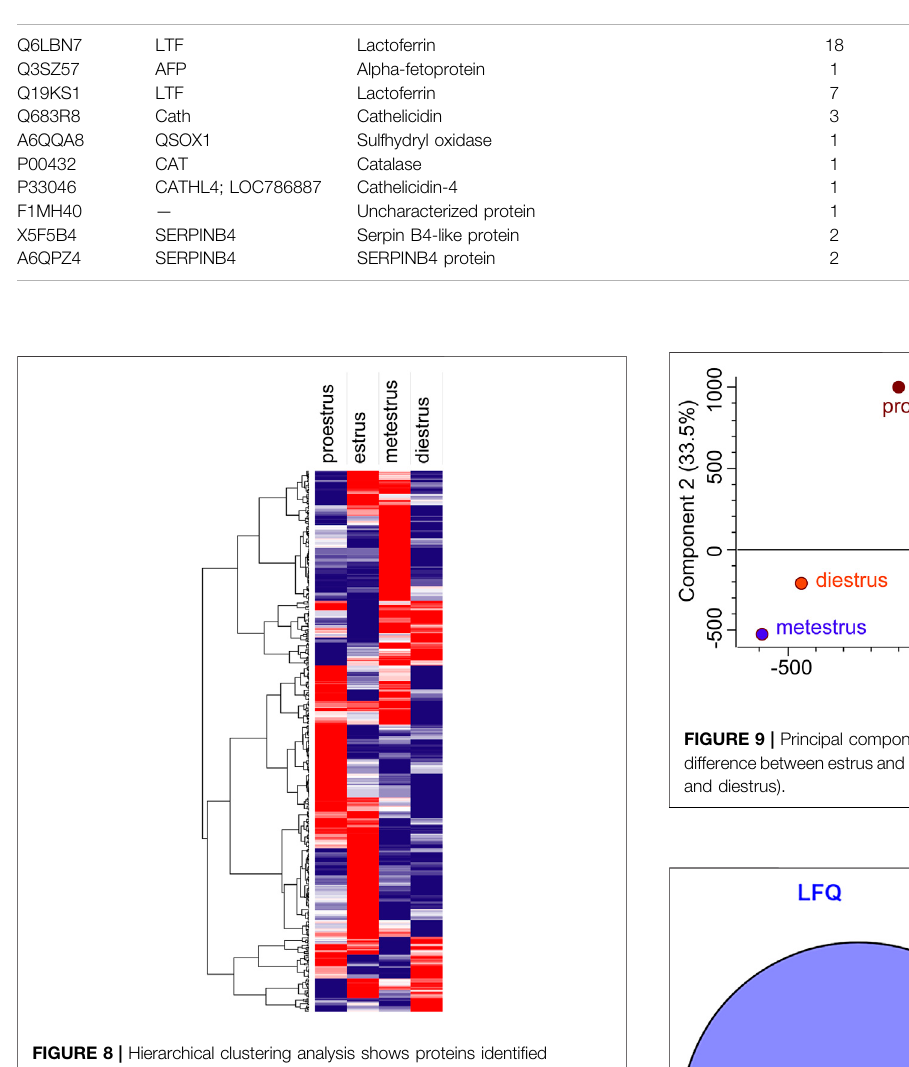
FIGURE 8 | Hierarchical clustering analysis shows proteins identi fi ed during proestrus, estrus, metestrus, and diestrus stages (red to blue indicates highest to lowest abundance).